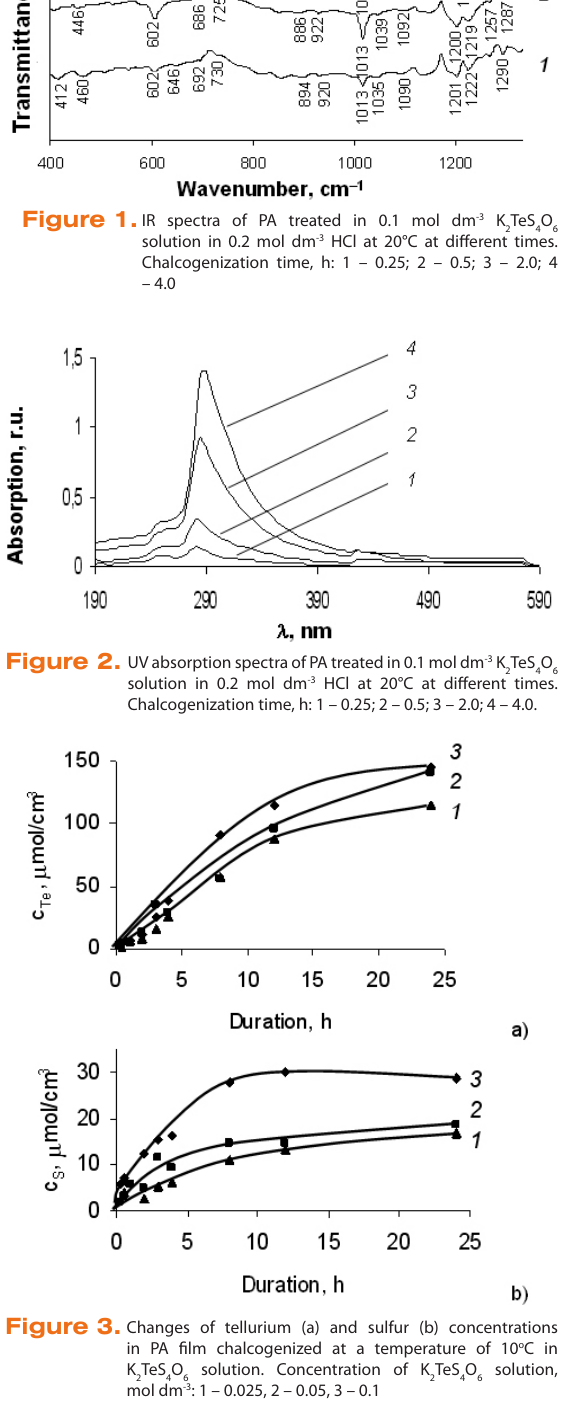
TeS O solution, 2 4 6